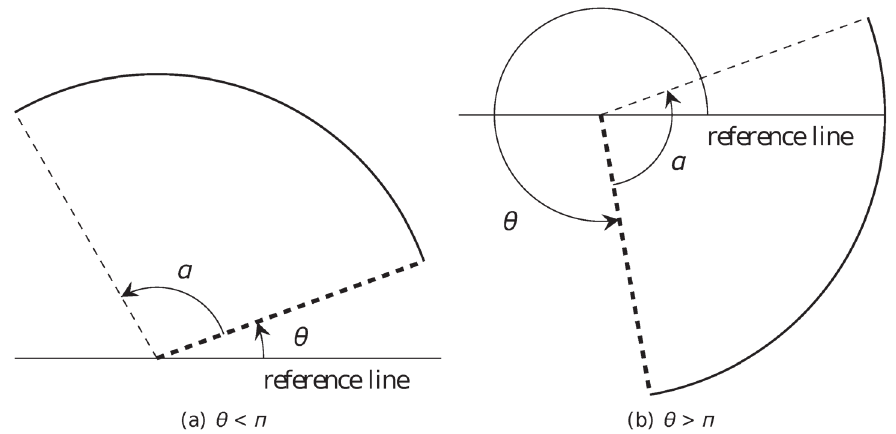
Fig 3. Definition of the angle θ of the orientation of an arc with a general opening angle α . An arc is drawn going counterclockwise from the thick dashed radial. θ is the (azimuth) angle made by the thick dashed radial and the (horizontal) reference line (see more in [ 27, p.